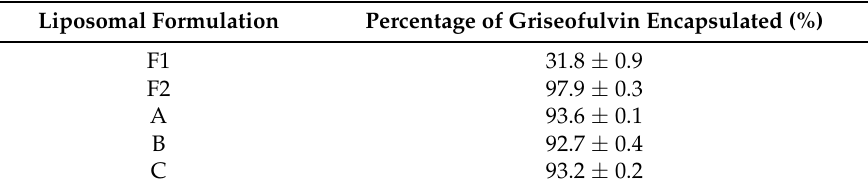
Table 4. Percentage of griseofulvin encapsulated in liposomal preparations (2 mg/g pro-lipo duo ® ) prepared by various techniques (Mean ± SEM, n =